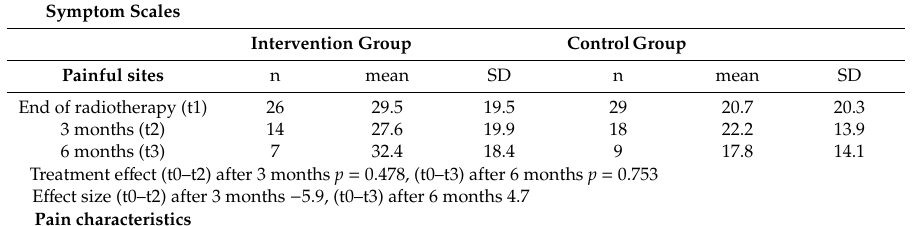
Table 4. E ff ects on QOL (EORTC QLQ-BM 22) questionnaire.